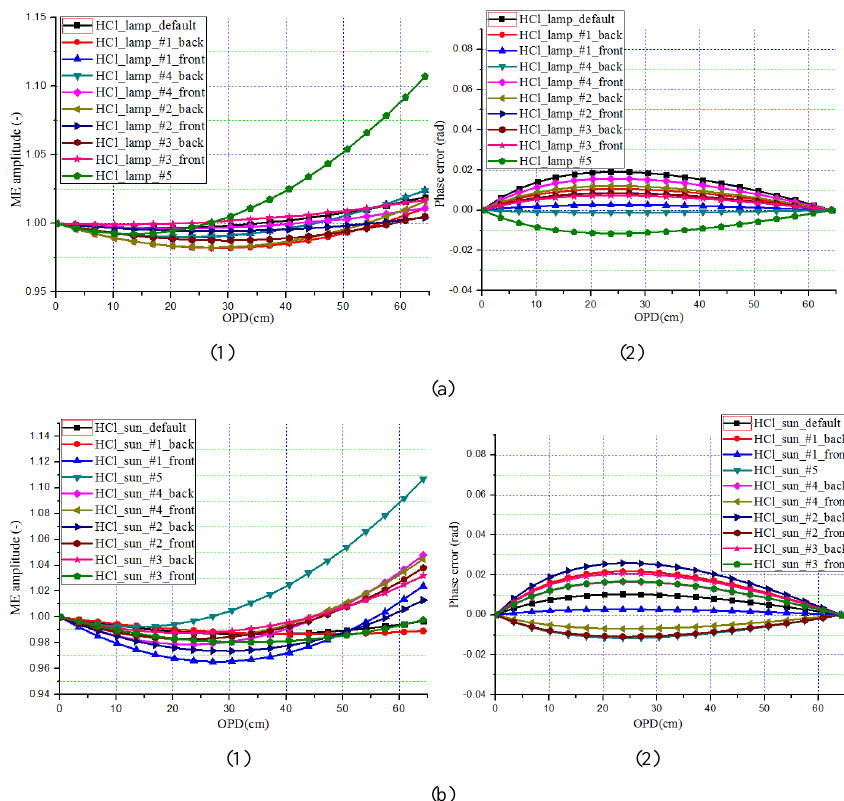
Figure 7. TCCON ILS retrievals for different attenuators. Panels (a) and (b) are ILS retrievals derived from lamp and sun cell measurements, respectively. (1) and (2) of each subplot represent the ME amplitude and phase error, respectively. “HCl_sun_#3_front” represents the sun HCl cell measurement performed by inserting the attenuator no. 3 in front of the interferometer. The nomenclature for other plot labels is